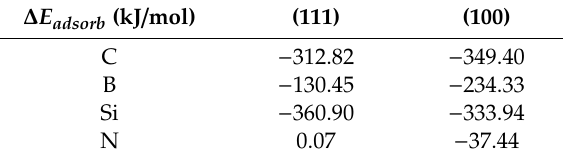
Table 1. The adsorption energy of CH 3 on undoped and substituted doped diamond